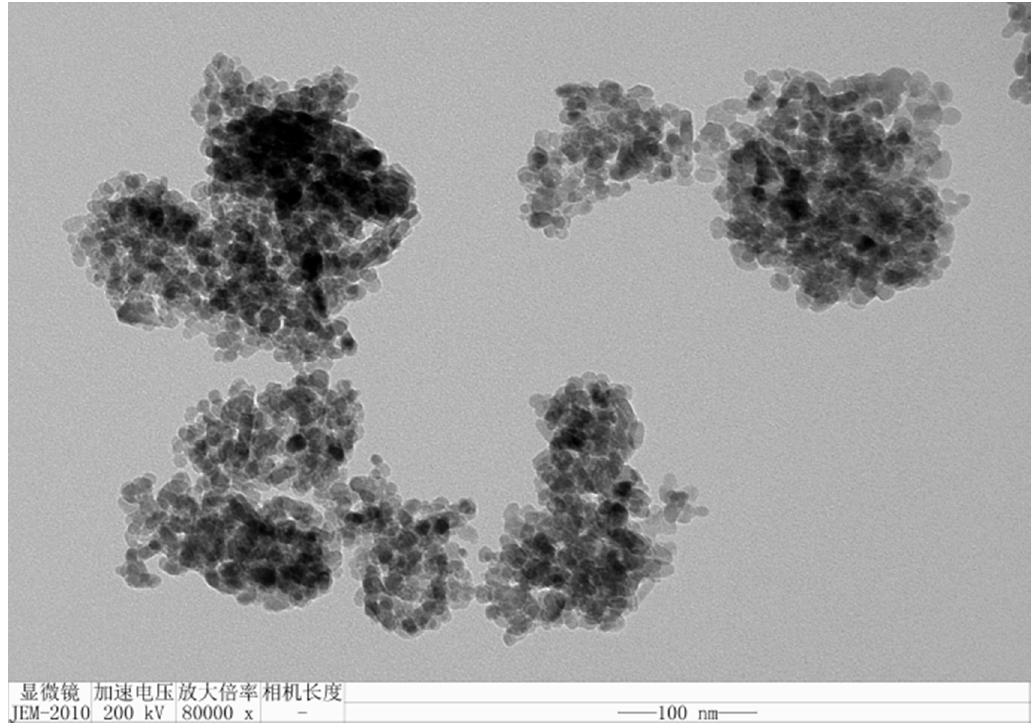
Figure 3. FETEM of ZnO after ball milling the precursor for 600 min followed by calcination at 300 °C.